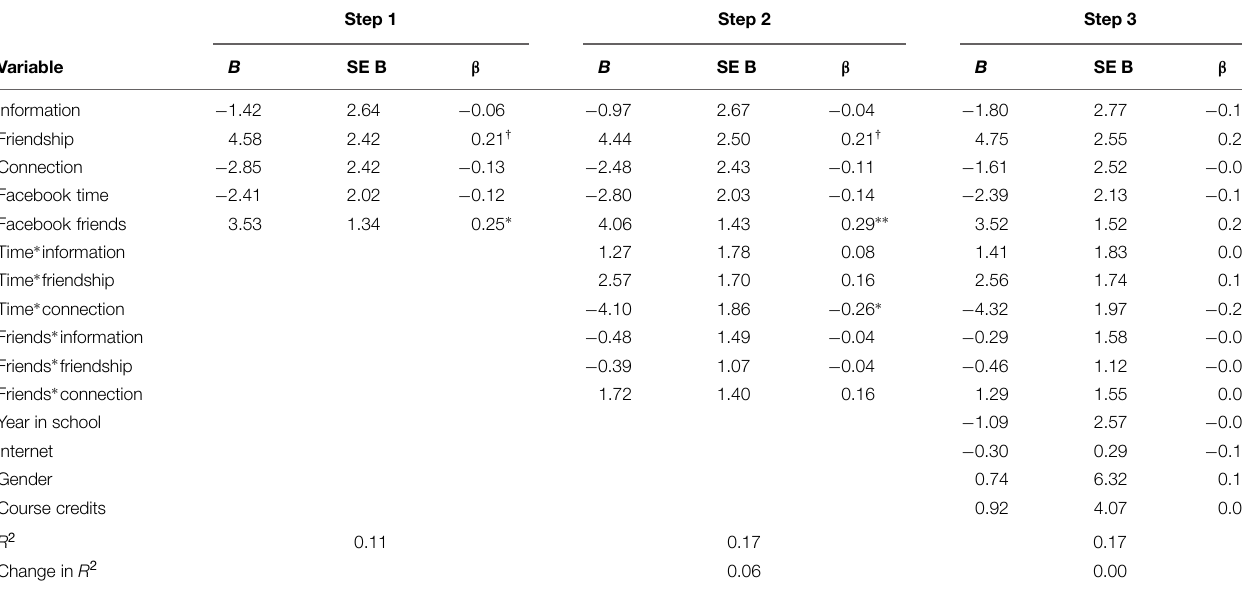
TABLE 4 | Summary of regression analyses for Facebook variables predicting Mental Health Index (MHI)